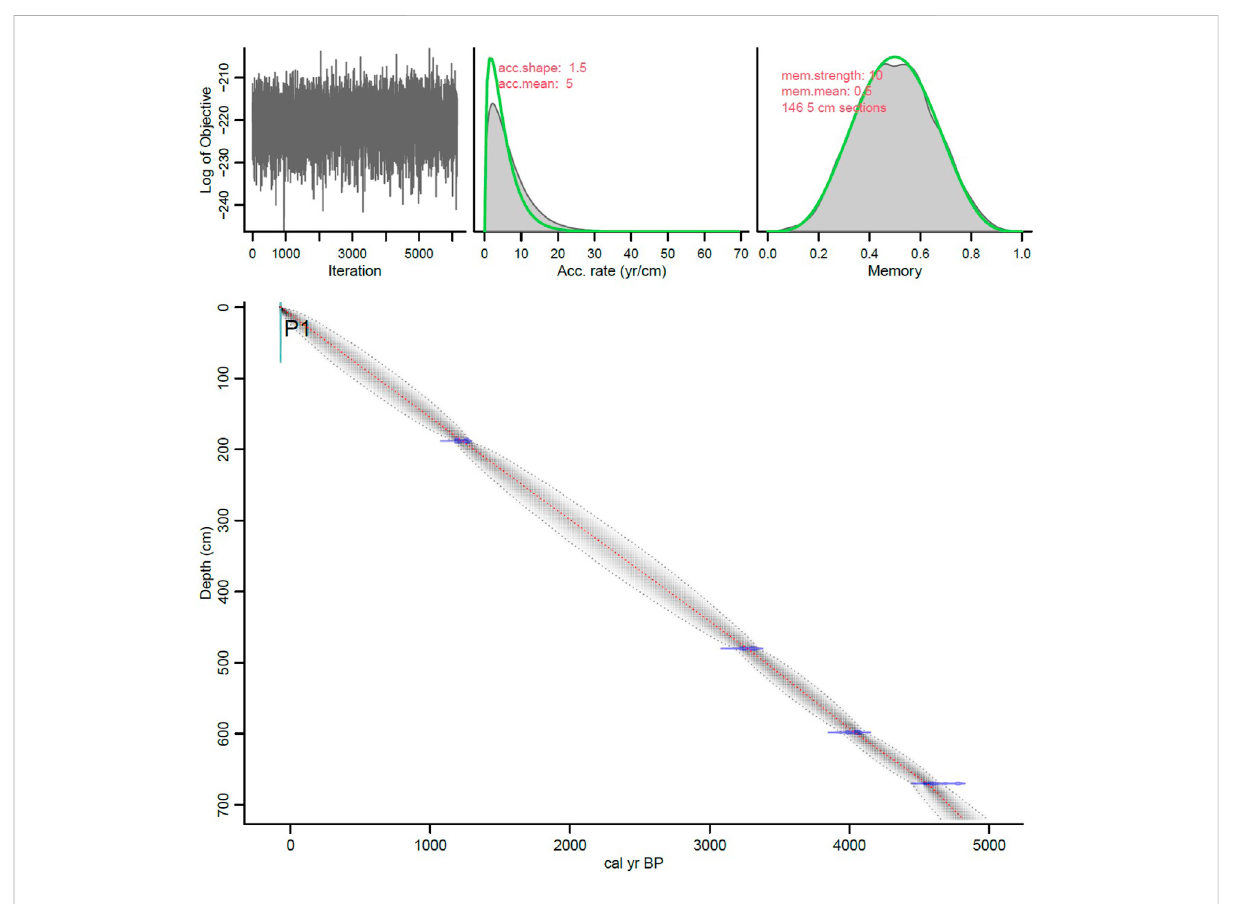
Age-depth model for the loess deposit of KLA